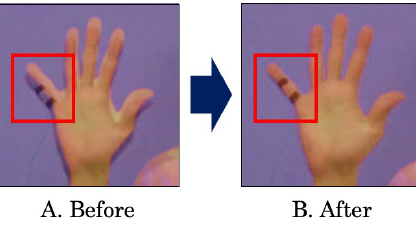
Figure 3. Result of overlapping.